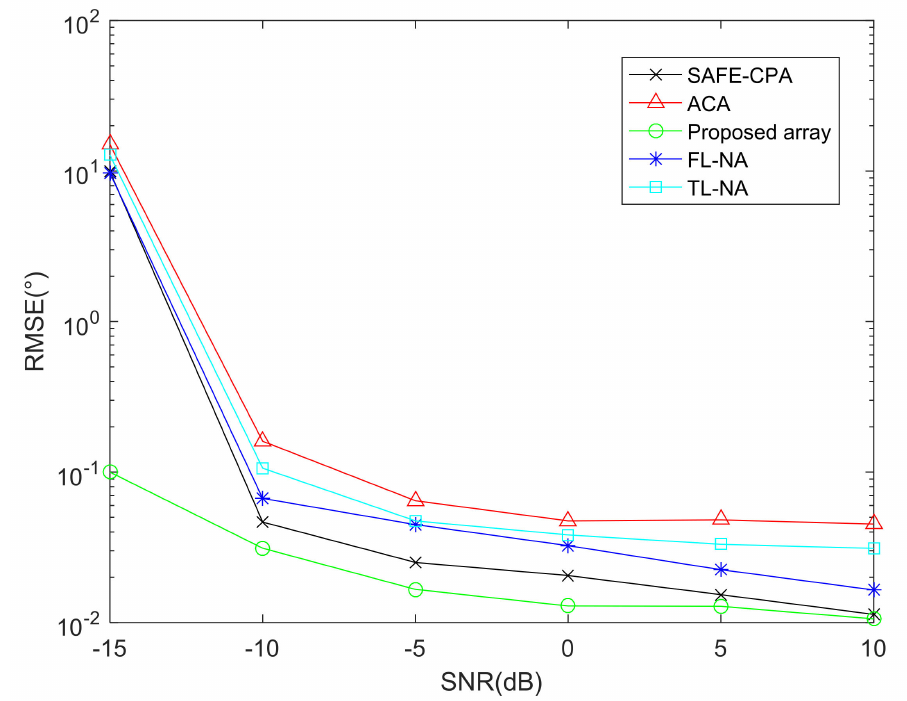
Figure 8. RMSE performance comparison of different